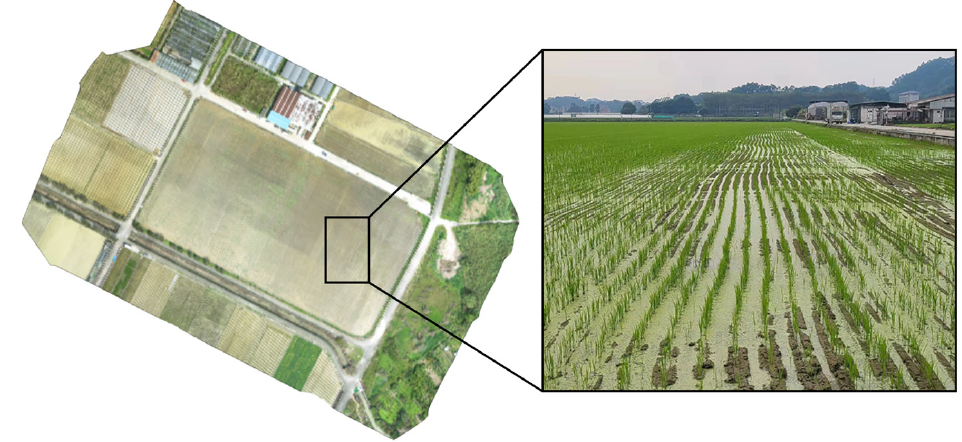
Figure 1. Data acquisition field.